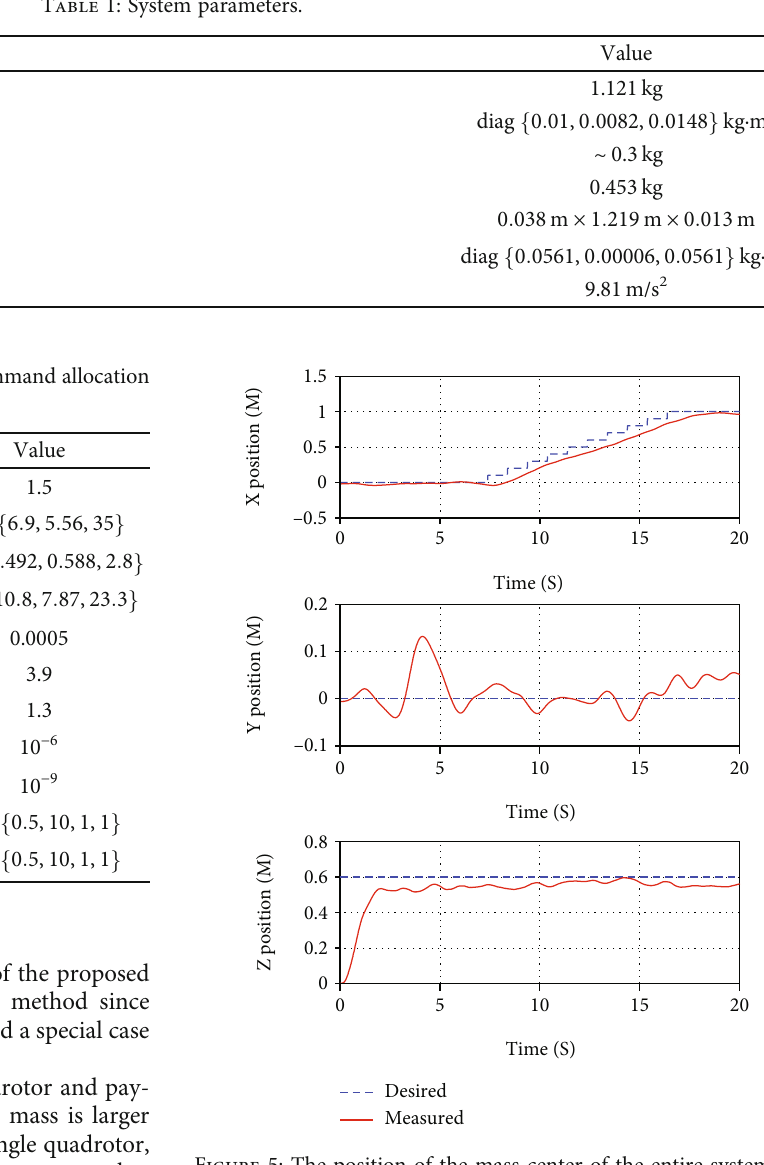
Figure 5: The position of the mass center of the entire system in the test in X direction.